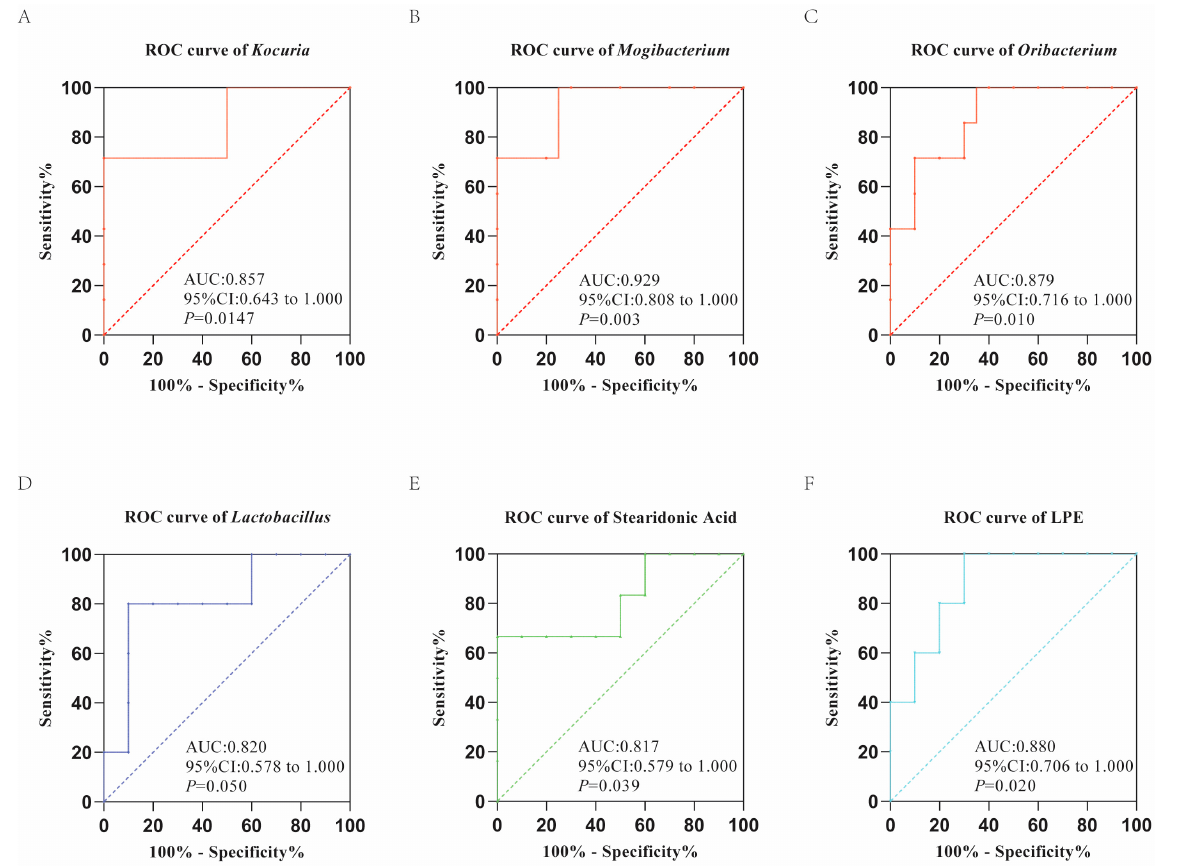
Figure 6. The ROC plot of significantly different gut microbes ( A – C ) and metabolites ( E ) for T2DM macaques. The ROC plot of significantly different gut microbes ( D ) and metabolites ( F ) for IGR macaques.